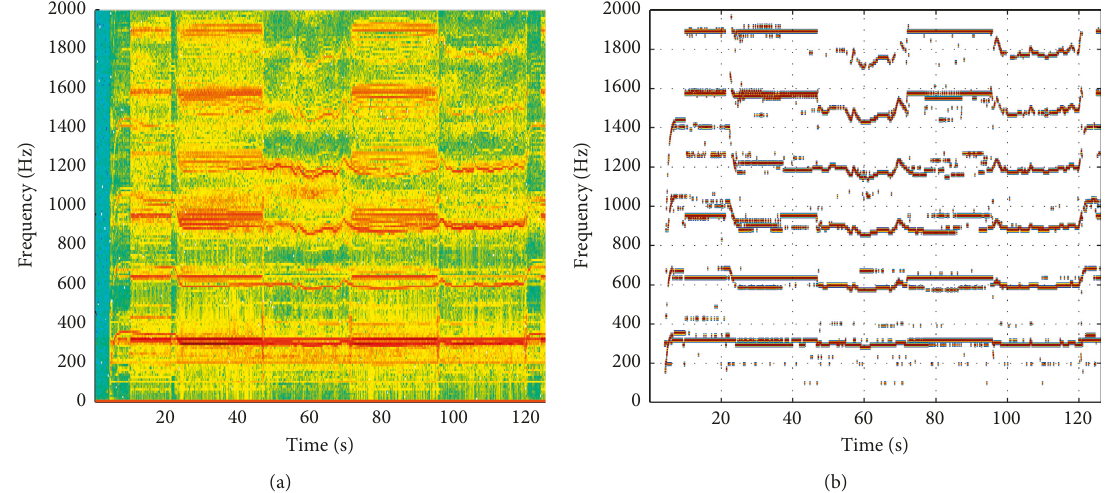
Figure 7: The spectrogram (a) with suitable peaks diagram (b) of the bed frame acceleration, for the first case of squared shape.